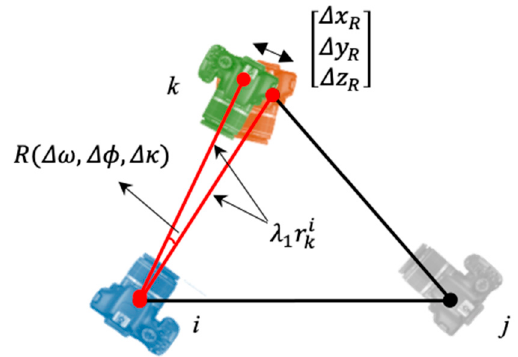
Figure 5. Discrepancy ( ∆ x R , ∆ y R , ∆ z R ) caused by the angular deviations ( ∆ ω , ∆ φ , ∆ κ ) at image k